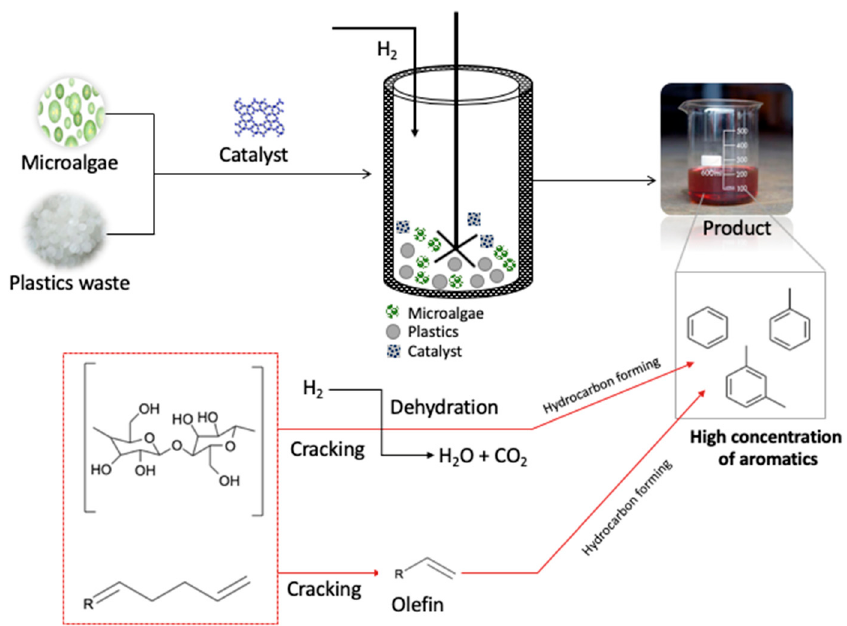
Figure 4. The illustration of pyrolysis process with the natural biomass and plastic waste as a feedstock. a